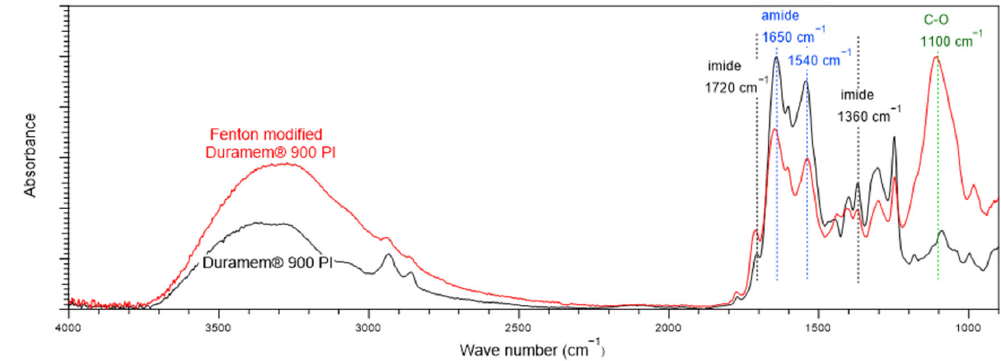
Figure 7. ATR ‐ FTIR spectra of pristine and Fenton ‐ modified PI membranes. Figure 7. ATR-FTIR spectra of pristine and Fenton-modified PI membranes.